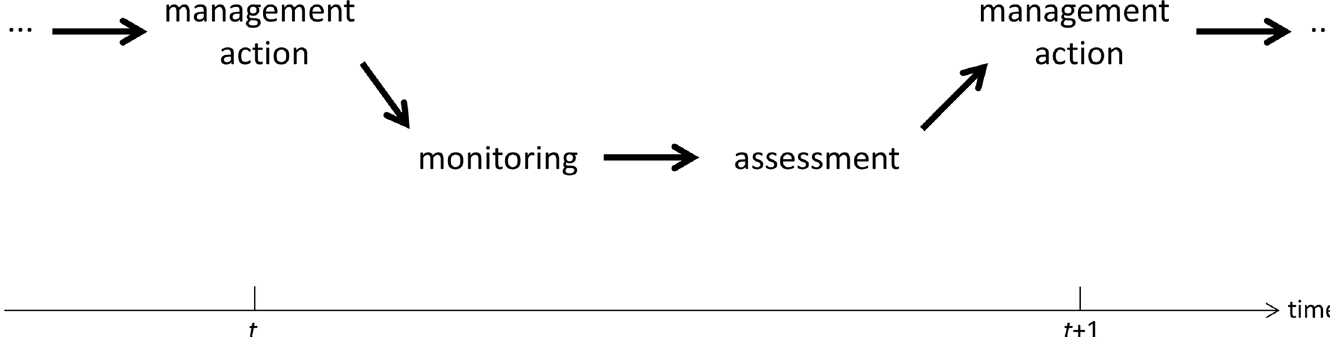
Fig 1. Adaptive management, with a repeated sequencing through time of decision making and taking actions; followed by monitoring of system responses; followed by assessment of data; followed by the integration of what is learned into future decision making.